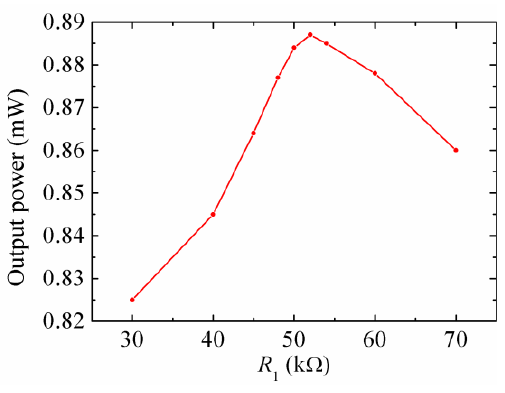
Figure 11. The output power of the stand-alone PEH for different R 1 at the resonant frequency.